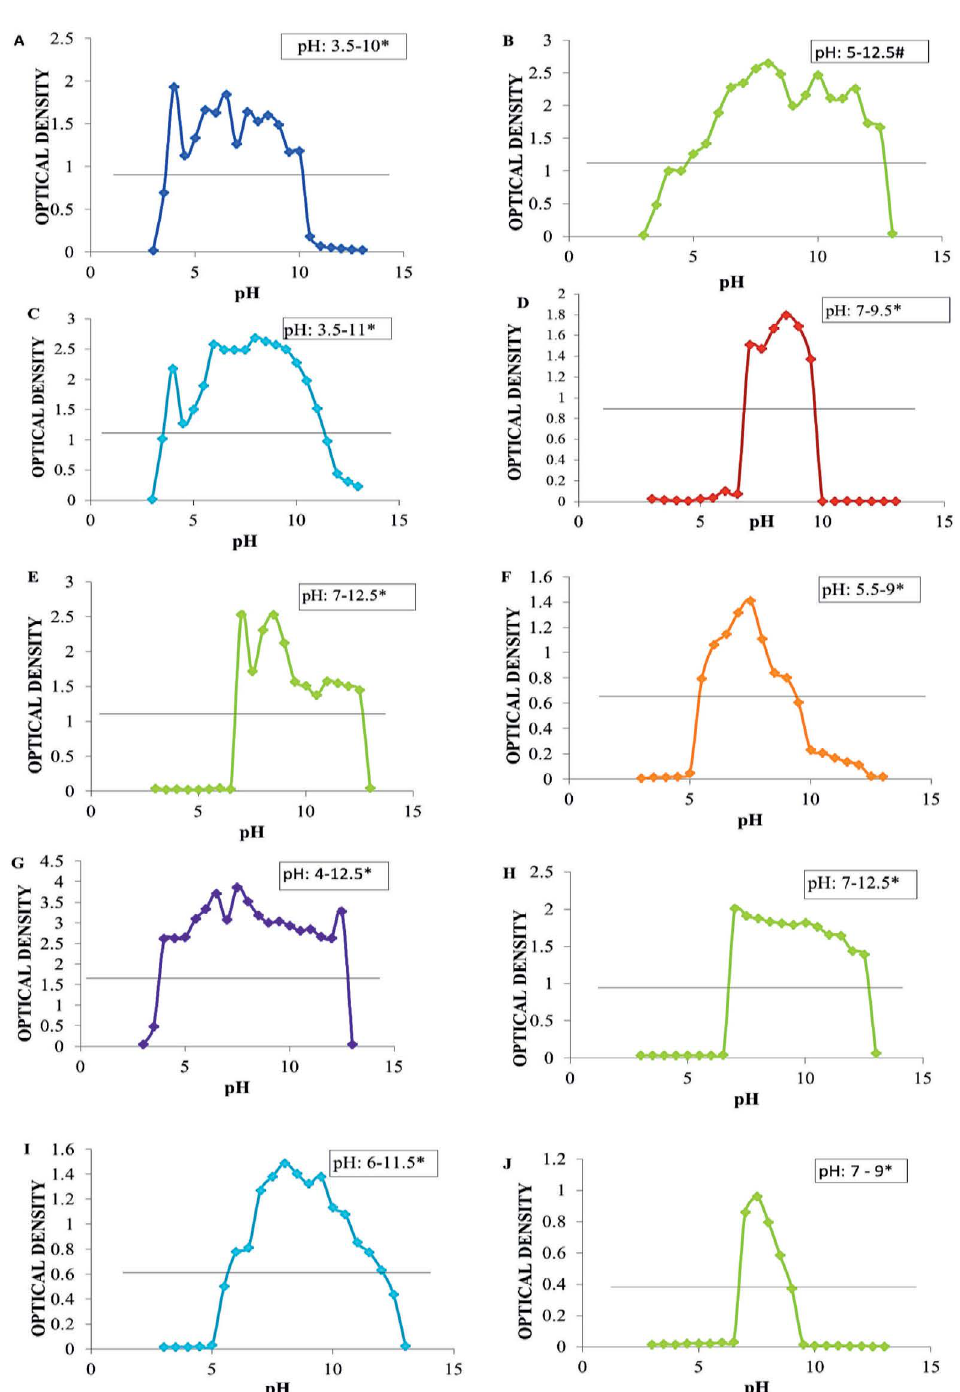
Fig. 2. Graph showing growth curve at different pH of A. T-1 isolate; B. T-2 isolate; C. E-2 isolate; D. O-2 isolate; E. R-1 isolate; F. MA-4 isolate; G. MA-5 isolate; H. MA-6 isolate; I. MA-9 isolate and J. RP-9 isolate. * indicates pH range of avg. growth (The pH range in which the growth (O.D.) of isolates remain at or above the 50% of the highest growth O.D. of respective isolates). Horizontal lines represent O.D. at 50% of the highest growth O.D of respective